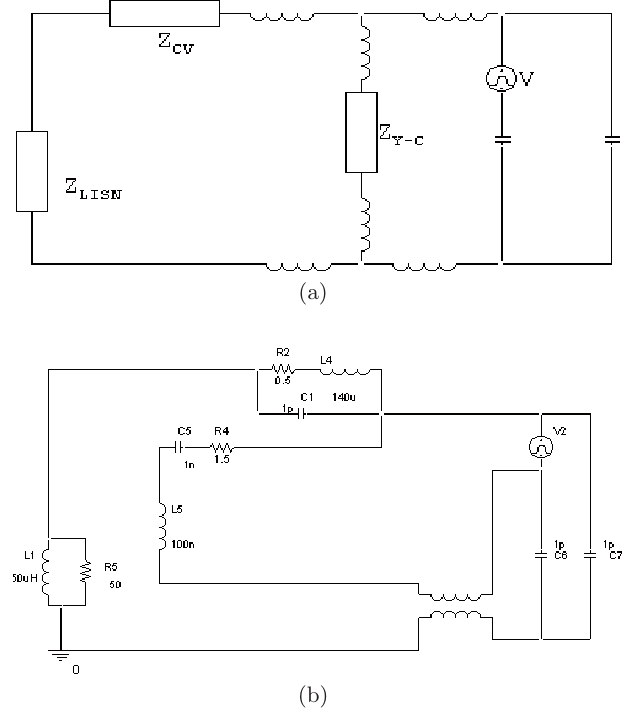
Fig. 4. The high frequency equivalent circuit model of the couplings for common mode currents. (a) Simplified equivalent circuit model of the couplings. (b) Equivalent circuit model with measured parameters values.